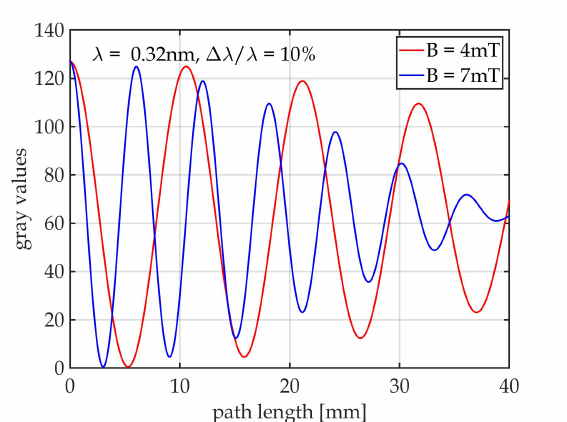
Figure 3. Contrast reduction of spin flips (minima and maxima in plot) due to a wavelength spread ± ∆ λ / λ ∼ 10% (mean λ = 0.32 nm), red and blue line corresponds to magnetic fields B = 4 mT and 7 mT. The larger ∆ λ / λ and B the shorter the path length for a number (6) of spin flips.